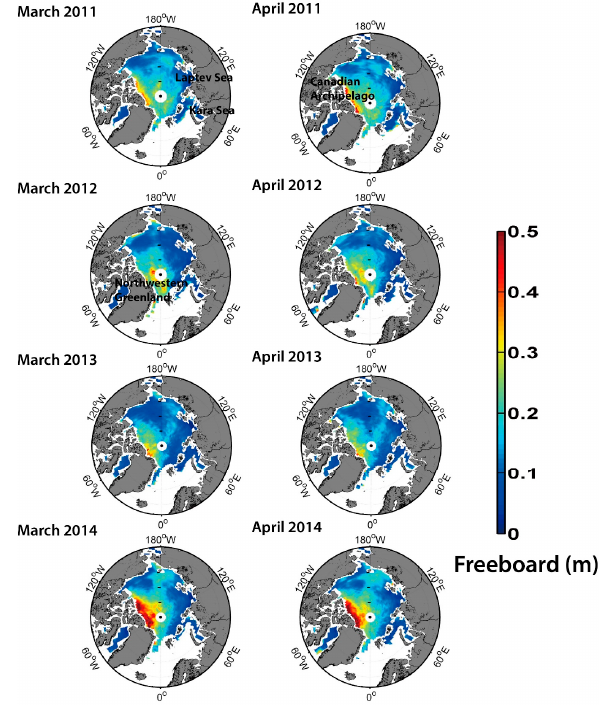
Figure 9. Arctic sea ice freeboard from CryoSat-2 for March and April between 2011 and 2014 based on the IC scheme. Non-sea ice areas were masked out using the EUMETSAT OSI SAF sea ice type data.